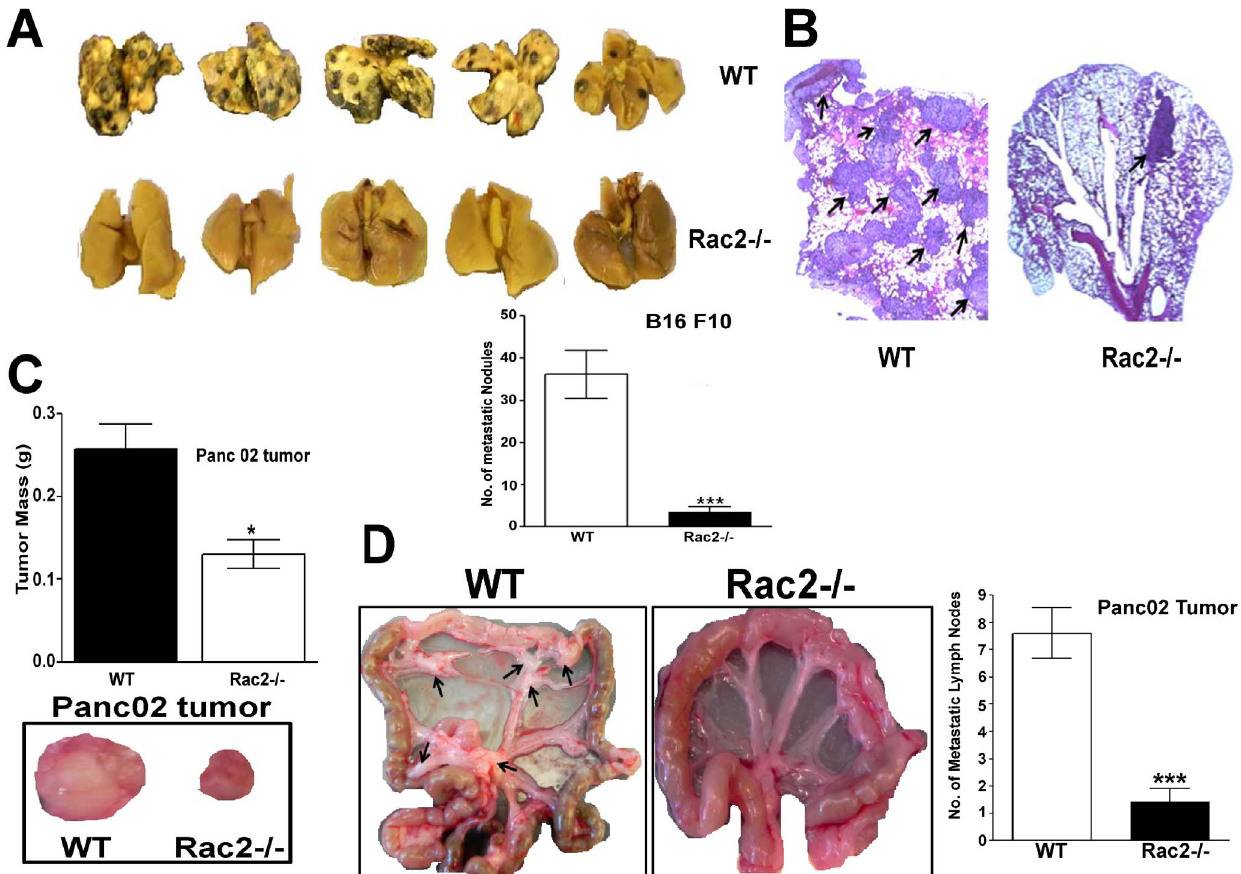
Figure 2. Rac2 promotes both experimental as well as spontaneous metastasis. (A) Experimental metastasis of B16 melanoma cells in WT and Rac2-/- mice (n=5). B16 F10 melanoma cells (5 6 10 5 cells) were injected through the tail vein, and after 15 days, the lungs were removed and the photographs were taken shown as upper panel in the figure. Lower panel shows mean number of tumor nodules visible on the surface of the lungs in WT and Rac2-/- mice. Surface tumor nodules in lungs were counted under dissecting microscope. Values are mean 6 SEM ( n =5 or 6; P , 0.001; pair wise two-sided Student’s t test). A marked suppression in the number of metastatic nodules was observed in Rac2-/- mice.(B) H&E-stained lung tissues demonstrating large macroscopic nodules (black arrows) were greatly increased in number and size in the WT vs. Rac2-/- mice, 15 d after B16 tumor cell injection. (C) Upper panel shows tumor mass of pancreatic tumors implanted orthotopically in WT and Rac2-/- mice. Panc02 (1 6 10 6 ) cells were injected in the pancreas of WT and Rac2-/- mice (n=10). Tumors were removed 30 days after tumor implantation. Values are mean 6 SEM ( n =10; P , 0.05; pair wise two-sided Student’s t test). Bottom panel shows representative images of pancreatic tumors isolated from pancreas of WT and Rac2-/- mice. (D) Left panel shows macroscopic view of Panc02 metastatic mesenteric lymph nodes from WT and Rac2-/- mice. Right panel shows number of metastatic mesenteric lymph nodes/mesentery. Values are mean 6 SEM ( n =5 or 6; P , 0.001; pair wise two-sided Student’s t test). The data are representative of three independent experiments